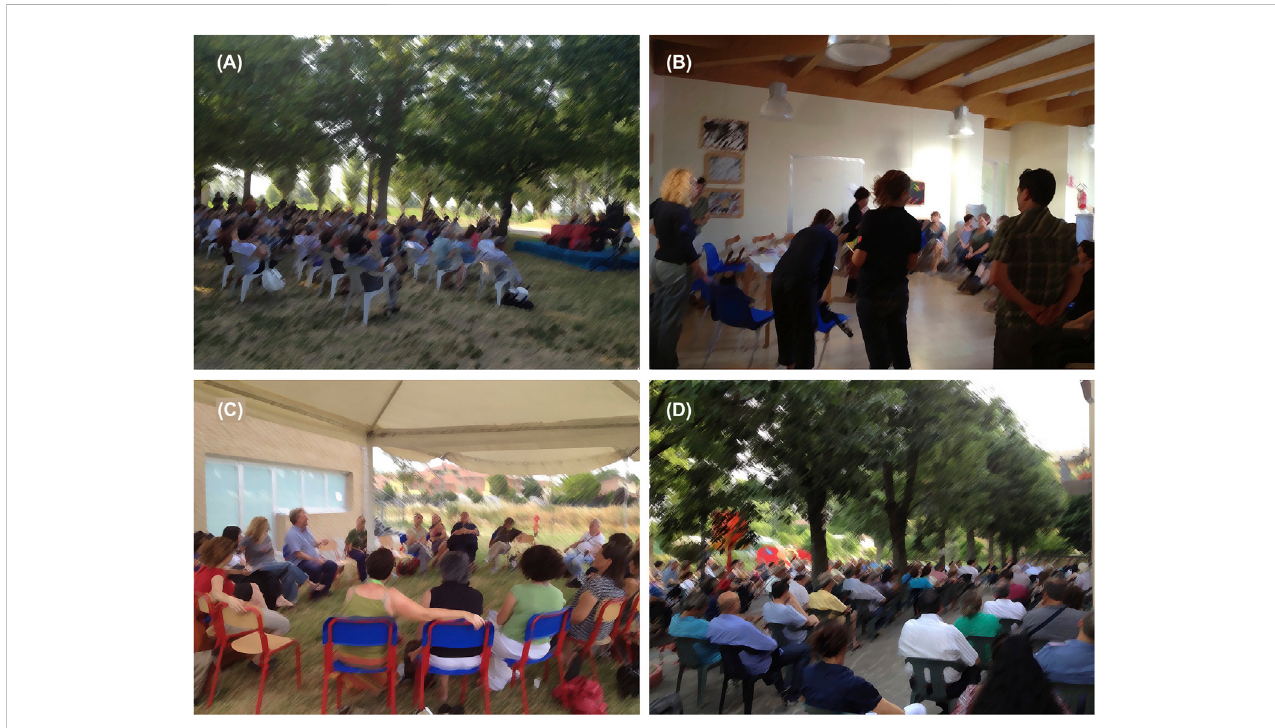
Pictures taken during the public meetings at different locations, with the population (A, D) or with teachers (B) and personnel of the national health services (C)